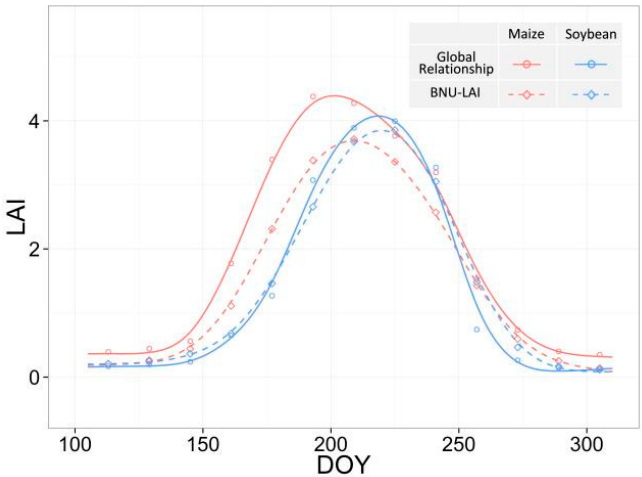
Figure 11. LAI time series of pure maize and soybean pixels in the Iowa validation site. LAI estimated by both the global EVI relationship and the BNU-LAI product are shown. Pure maize or soybean pixels are those that have more than 90% area planted with maize or soybean respectively. The figure shows the average value of all pure pixels. The smooth curves were generated from polynomial regression.